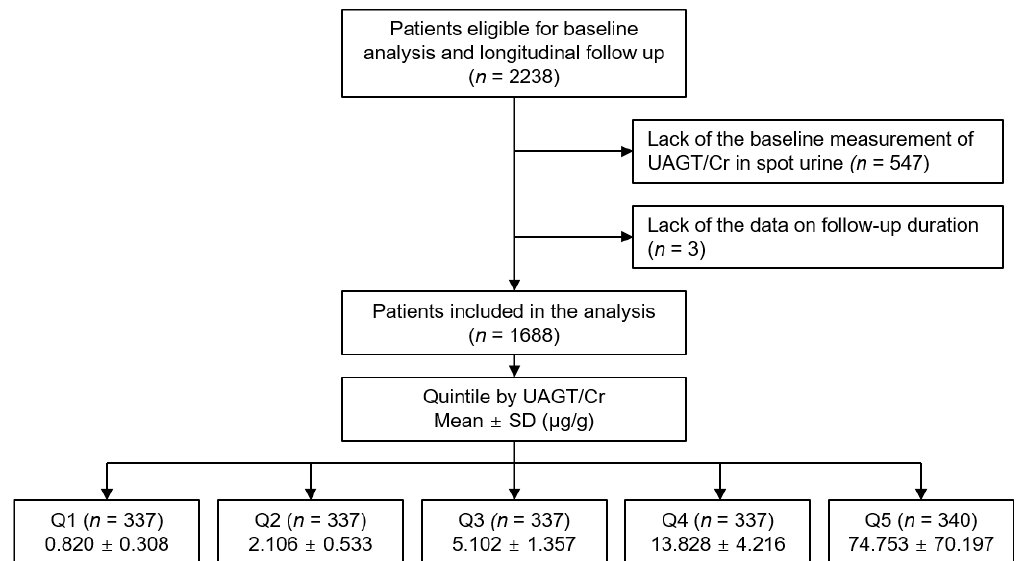
Figure 1. Flow diagram of the study participants. Abbreviations: Q1, 1st quintile; Q2, 2nd quintile; Q3, 3rd quintile; Q4, 4th quintile; Q5, 5th quintile; UAGT/Cr, urinary angiotensinogen-to-creatinine ratio.